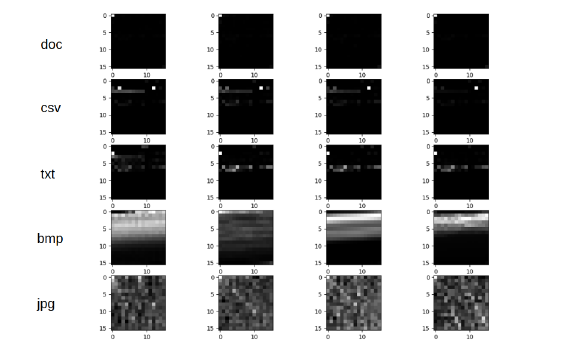
Figure 1. Byte Histogram of several file types converted to Greyscale